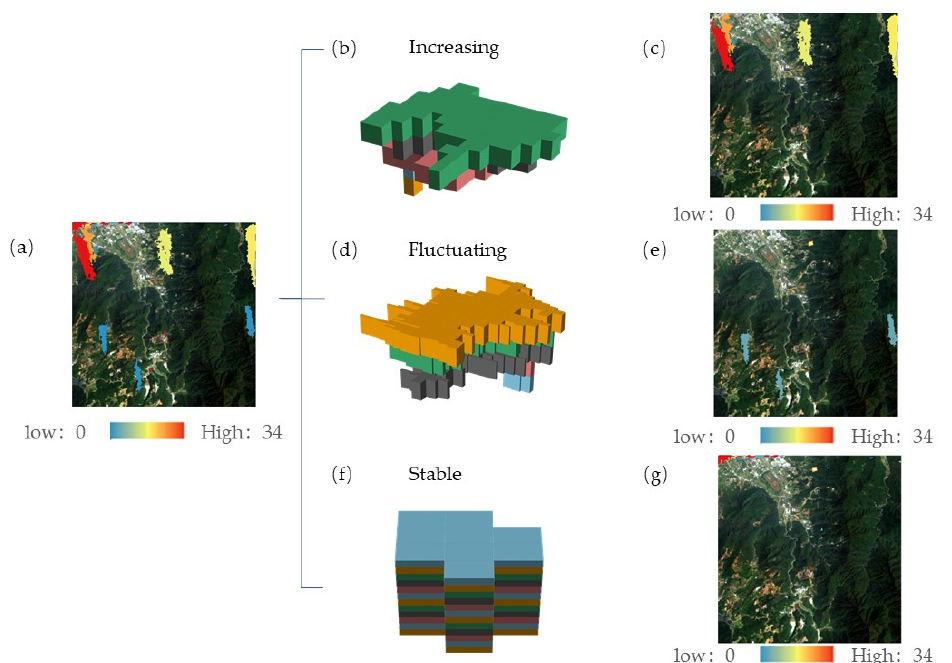
Figure 10. ( a ) Spatial distribution map of the mean time length of the LS IST-cube. ( b ) Actual LS and increasing IST-cube diagram, containing five layers representing five years, with an increasing number of pixels per year, conforming to the LS and increasing IST-cube classes. ( c ) Spatial distribution map of the mean time length of the LS and increasing IST-cube classes. ( d ) Actual LS and fluctuating IST-cube diagram, containing six layers representing six years, with a fluctuating number of pixels per year, conforming to the LS and fluctuating IST-cube classes. ( e ) Spatial distribution map of the mean time length of the LS and fluctuating IST-cube classes. ( f ) Actual LS and stable IST-cube diagram, containing 13 layers representing 13 years, where the number of pixels per year is constant, conforming to the LS and stable IST-cube classes. ( g ) Spatial distribution map of the mean time length of the LS and stable IST-cube classes.